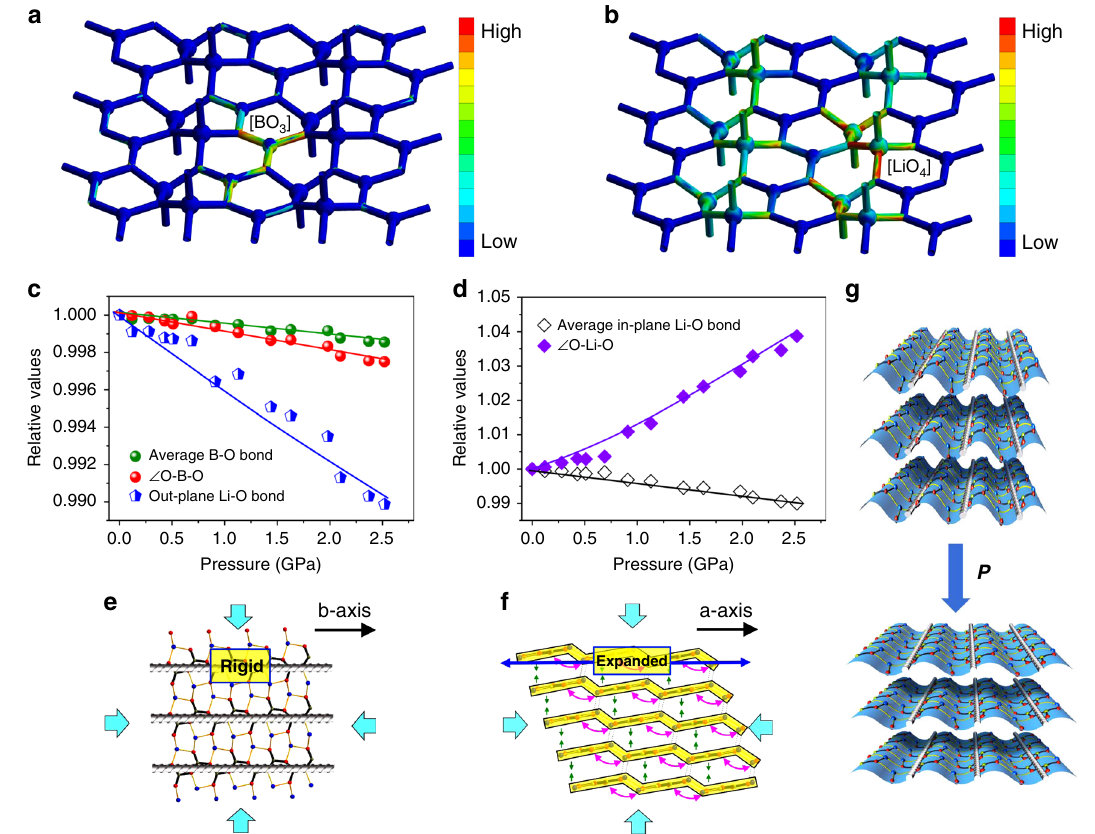
Fig. 2 Microscopic mechanism for the simultaneous NLC, ZLC, and PLC in LiBO 2 . a Stress and b Strain distribution in LiBO 2 structure, respectively, by fi nite element analysis. c , d Pressure-induced modi fi cation of bond lengths and bond angles responsible for ZLC and NLC. e Schematic for the ZLC behavior. f Schematic for the NLC behavior. g Schematic for the mechanism of the pressure-responding behaviors originated from the CGL structure. The [BO 2 ] ∞ chains are represented by gray bars and the [LiO 3 ] bases are represented by blue